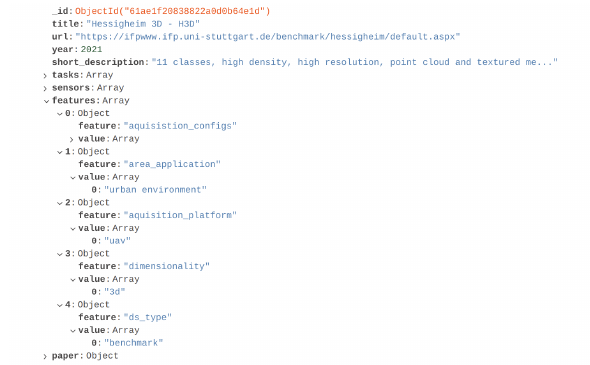
Figure 3. Example of a MongoDB benchmark document. The structure of the attributes in the ’features’ field is based on the MongoDB attribute pattern.